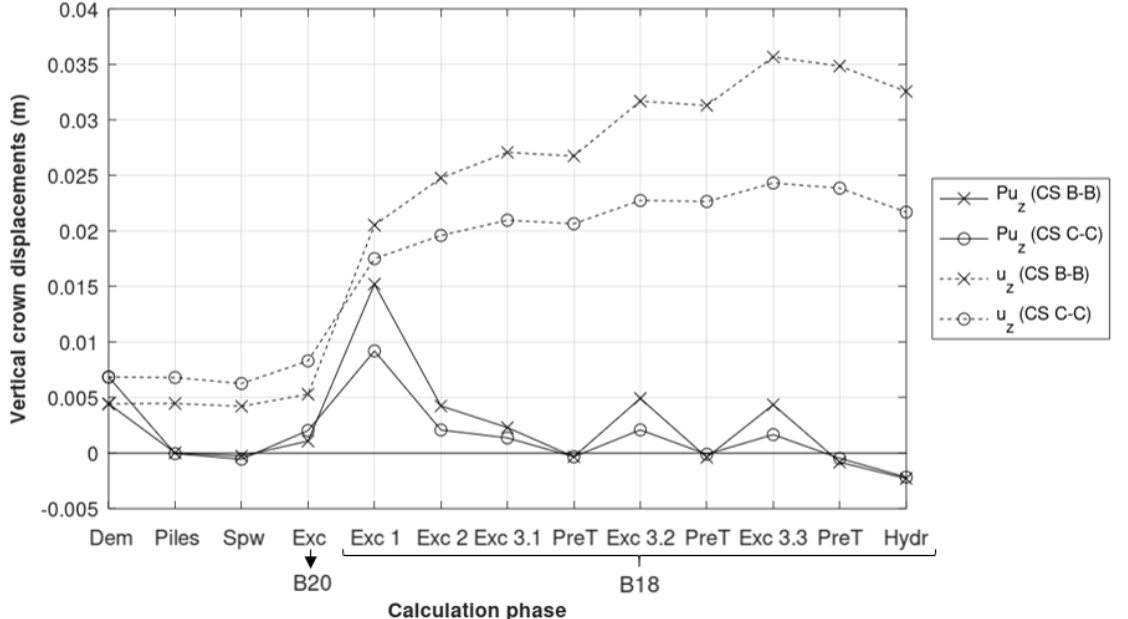
Fig. 16. Development of vertical crown displacements at different